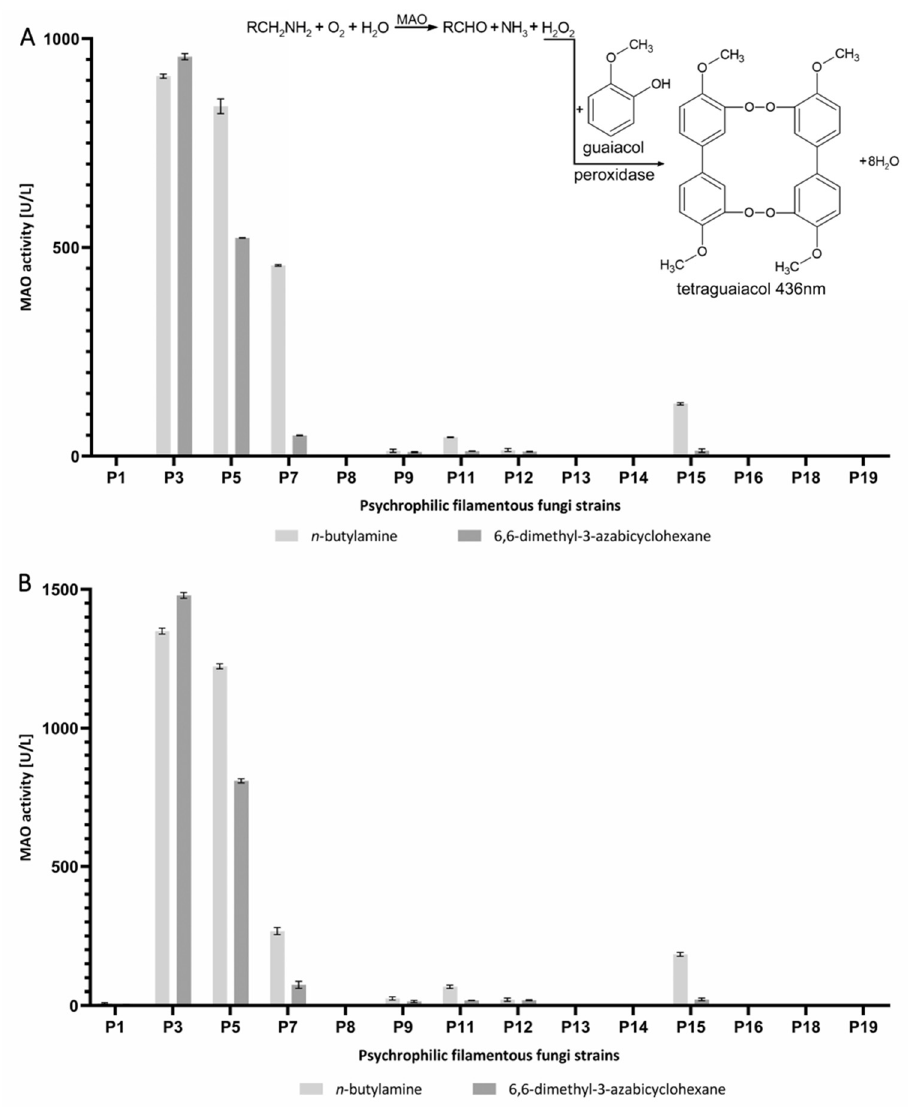
Figure 2. MAO biosynthesis in 14 psychrophilic fungi strains. The activity was measured towards a primary amine ( n -butylamine) and a secondary amine (6,6-dimethyl-3-azabicyclohexane), for each substrate. The reaction was carried out at 30 °C for 30 min with continuous shaking in 10 mM potassium phosphate buffer pH 7.0. ( A ) Activity after the growth in the induction medium, without inoculation from a solid culture; insert: scheme of the measurement of MAO activity in psychrophilic fungi strains; absorbance of tetraguaiacol is measured at 436 nm. ( B ) Activity after the growth in the induction medium, with inoculation from a solid culture.